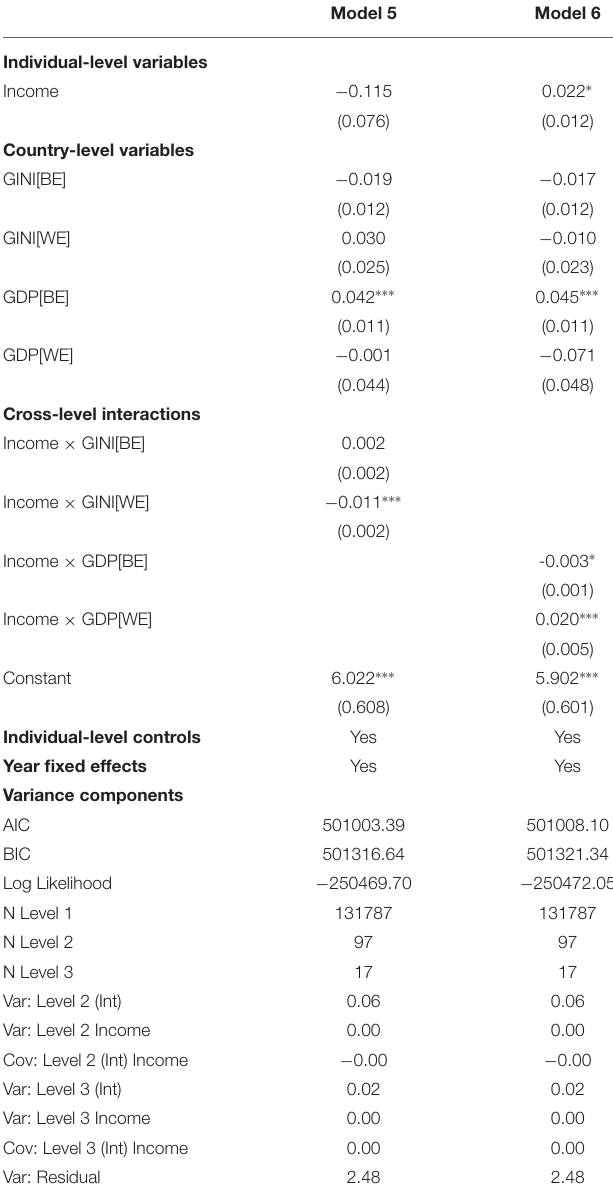
TABLE 4 | Hybrid multilevel regression models of individual support for